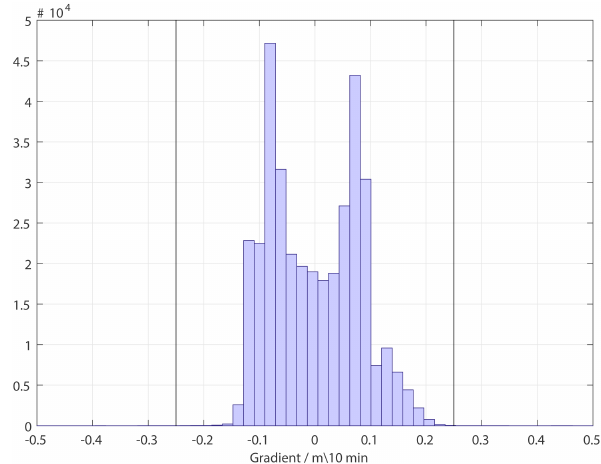
The histogram is showing the gradient between two adja- cent data points. Vertical lines indicate the 0.25m10min − 1 thresh- old for the removal of